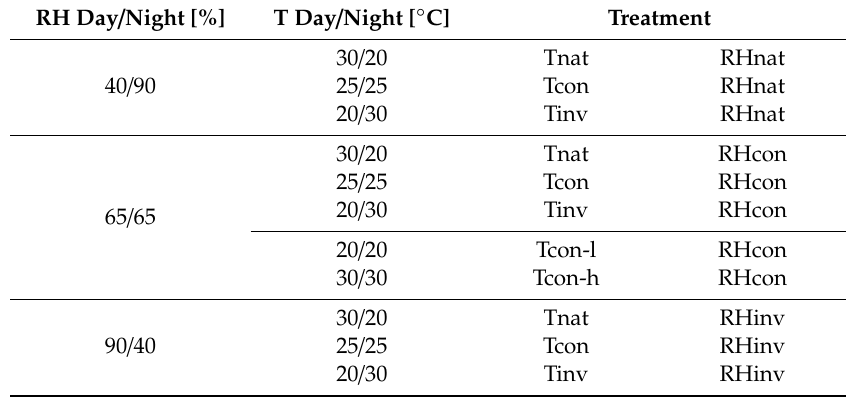
Table 6. Cultivation conditions for rice plants starting 35 days after sowing until 49 days after sowing. RH Day / Night [%] T Day / Night [ ◦ C] Treatment 30 / 20 Tnat RHnat 40 / 90 25 / 25 Tcon RHnat 20 / 30 Tinv RHnat 30 / 20 Tnat RHcon 25 / 25 Tcon RHcon 20 / 30 Tinv RHcon 65 / 65 20 / 20 Tcon-l RHcon 30 / 30 Tcon-h RHcon 30 / 20 Tnat RHinv 90 / 40 25 / 25 Tcon RHinv 20 / 30 Tinv